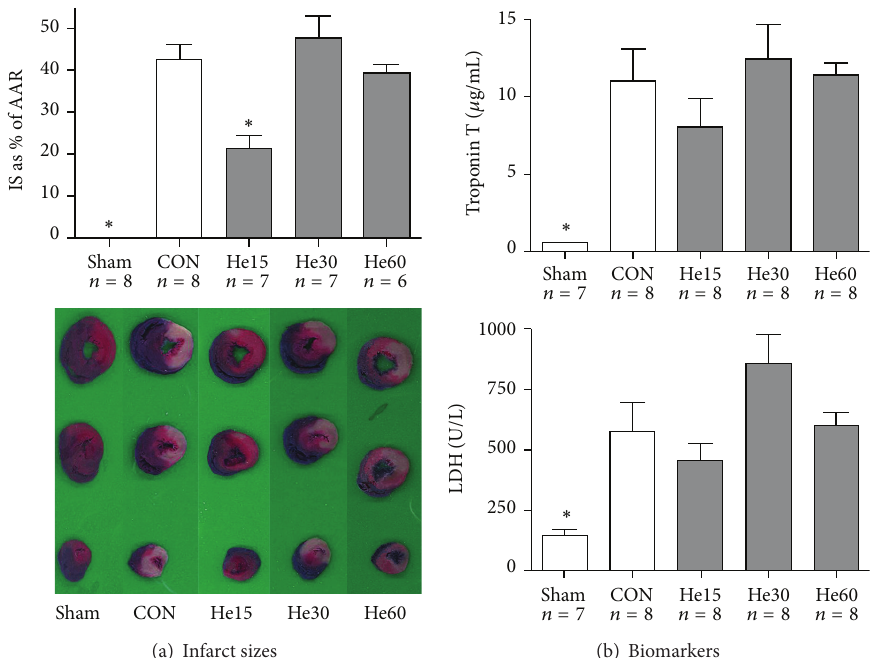
Figure 1: Infarct size and biomarkers after 120 minutes of reperfusion. Data are shown as mean ± S.E.M. ∗ 𝑃 < 0.05 versus CON. Amount of experiments in each group is shown below individual bars. (a) Infarct sizes as percentage of the area at risk. Underneath the graph, pictures of representative slices of myocardium are shown for each group. (b) Troponin T and LDH levels in the circulation after 120 minutes of